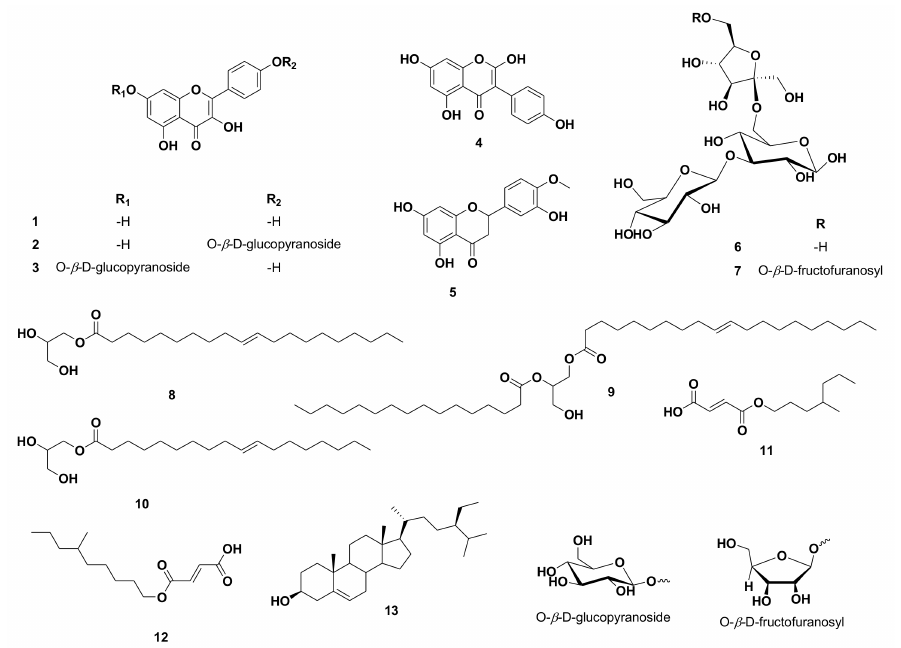
Figure 1. Structures of compounds isolated from Citrus reticulata